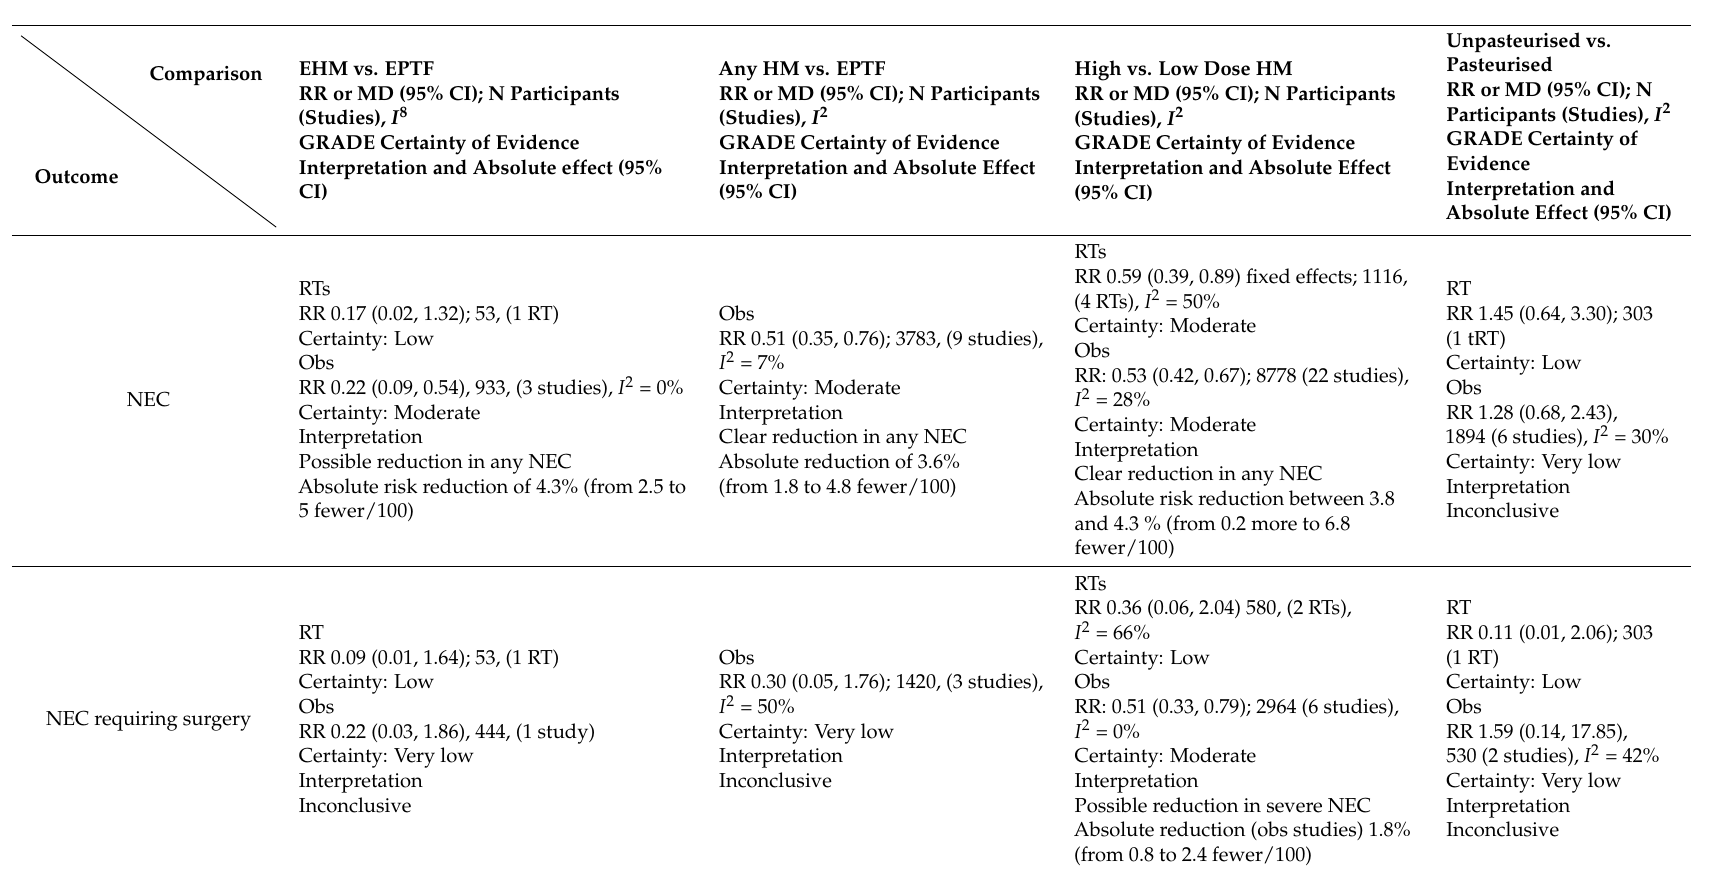
Table 2. Summary of